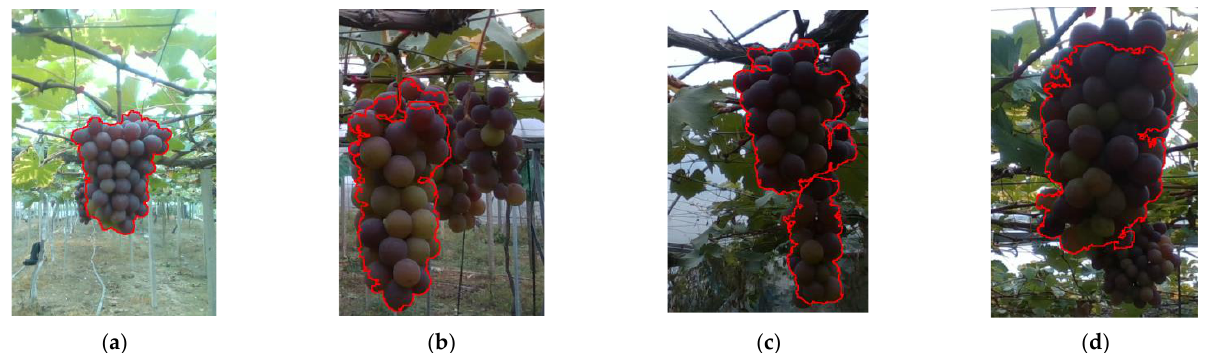
Figure 23. Example of segmentation result of overlapping grape clusters. ( a , b ) The successful examples, and ( c , d ) the failed examples.